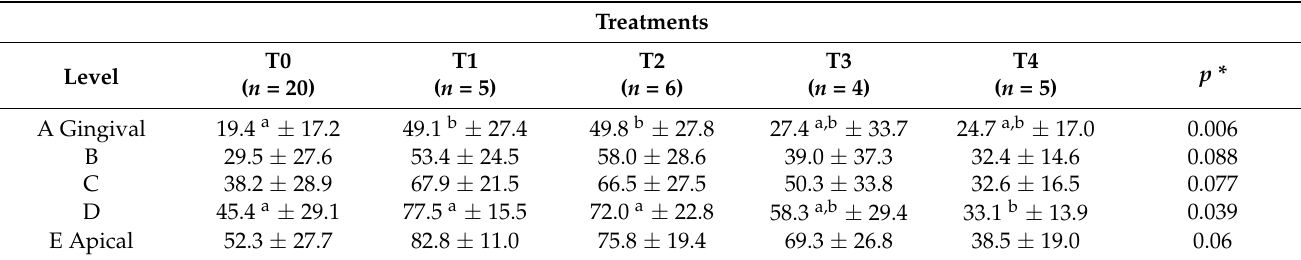
Table 1. Bone healing percentage (%) of control (T0) and four different graft treatments with DAM, ASCs, and ECM (T1 to T4), on five levels of furcation defects (A–E).